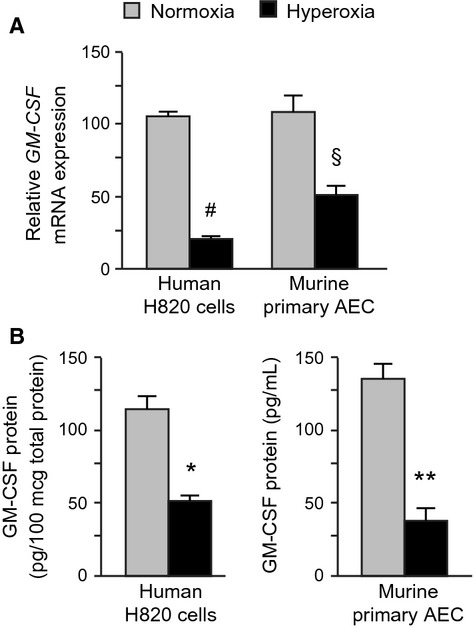
Effect of exposure to hyperoxia on lung epithelial cell expression of GM-CSF. Human H820 cells and primary murine AEC were exposed to hyperoxia (80% oxygen/5% CO2; black bars) or normoxia (21% oxygen/5% CO2, gray bars) for a total of 48 h. After 32 h, the culture medium was replaced with fresh medium, and the cells continued in hyperoxic or normoxic conditions for 16 h further for determination of GM-CSF mRNA in cell lysates and GM-CSF protein in the culture supernatant. GM-CSF mRNA was measured by RT-PCR, normalized to GAPDH levels and expressed relative to the first sample in normoxia (100%) (A). GM-CSF protein in the culture supernatants was measured by ELISA (R&D Systems). Data are expressed as pg GM-CSF/ml (B). All data are expressed as means ± SEM, n = 3, and are representative of three independent experiments. #P < 0.0001; §P = 0.011; *P < 0.001; **P < 0.01.